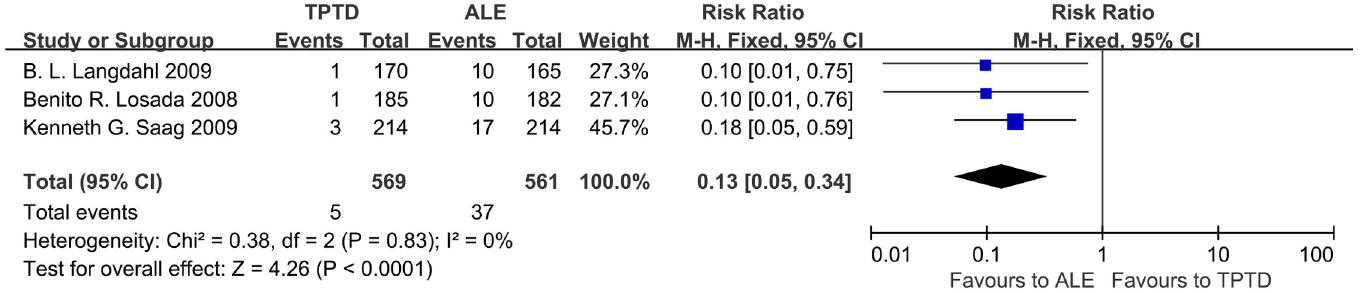
Fig 4. Forest plots of incidence of vertebral